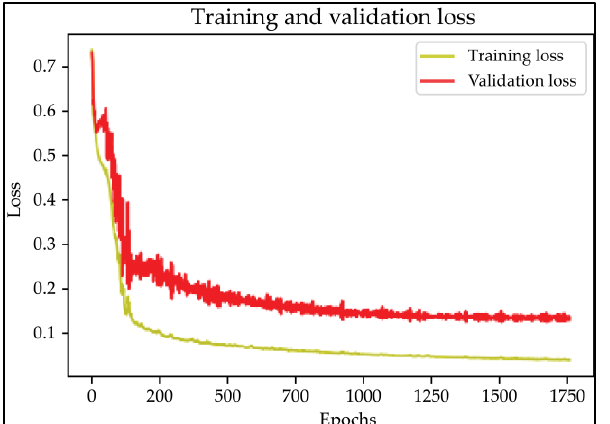
Figure 5. The training and validation loss curve of the 3D UNet architecture CT-scan binary-class segmentation learning process. Table 8. Comparison between ground truth and prediction results of lung and infection segmenta- tion with 3D UNet architecture.